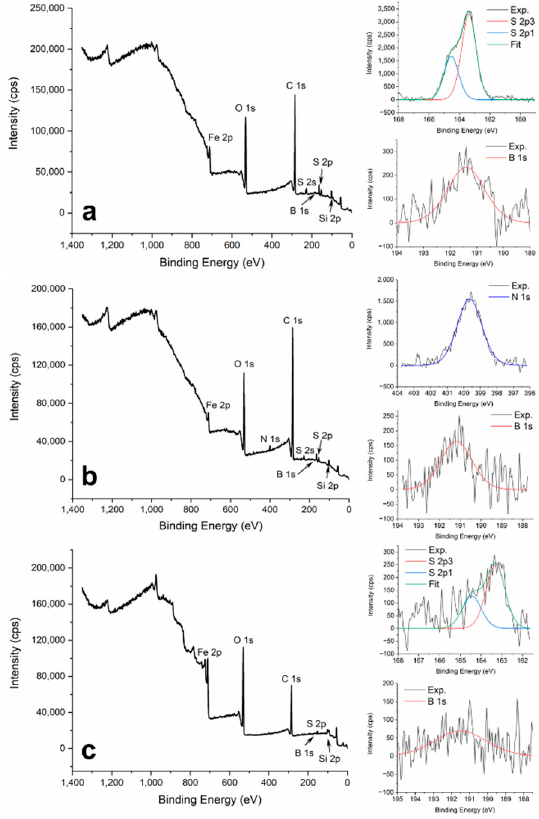
Figure 4. XPS spectra of the phenylboronic ‐ acid ‐ modified magnetic nanoparticles ( a ) Fe 3 O 4 @MPTES@VPBA, ( b ) Fe 3 O 4 @MPTES@AAPBA and ( c ) Fe 3 O 4